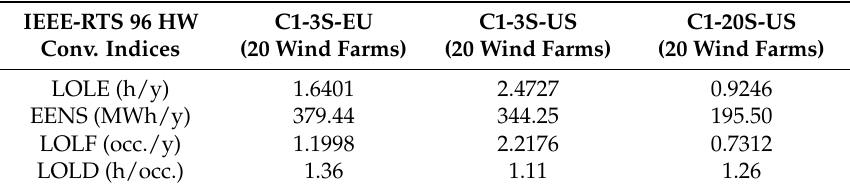
Table 5. Operating reserve-IEEE-RTS 96 HW with wind series.